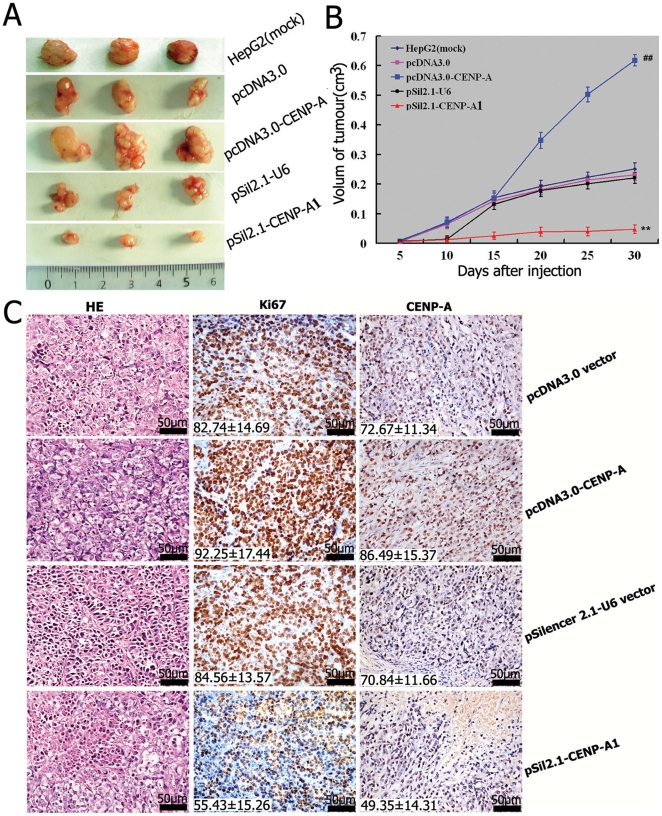
Effects of CENP-A overexpression or knockdown on tumorigenicity in nude mice.The transfected or untreated HepG2 cells were injected into nude mice, as described in Materials and methods. Tumor volume was determined every 5 days for 30 days. At the end of the experiment, animals were sacrificed and tumors were excised for volume measurement and histological study. A: Representative photographs of tumors for each treatment. B: Growth curve of tumor xenografts. ##
P<0.01, compared to the pcDNA3.0 empty vector; **
P<0.01, compared to the pSil2.1-U6; n = 4. C: The resected tumors were stained with HE and antibodies against Ki-67 and CENP-A. Representative images of the staining are shown. The percentages of Ki-67-positive and CENP-A-positive cells were inserted in the corresponding images.